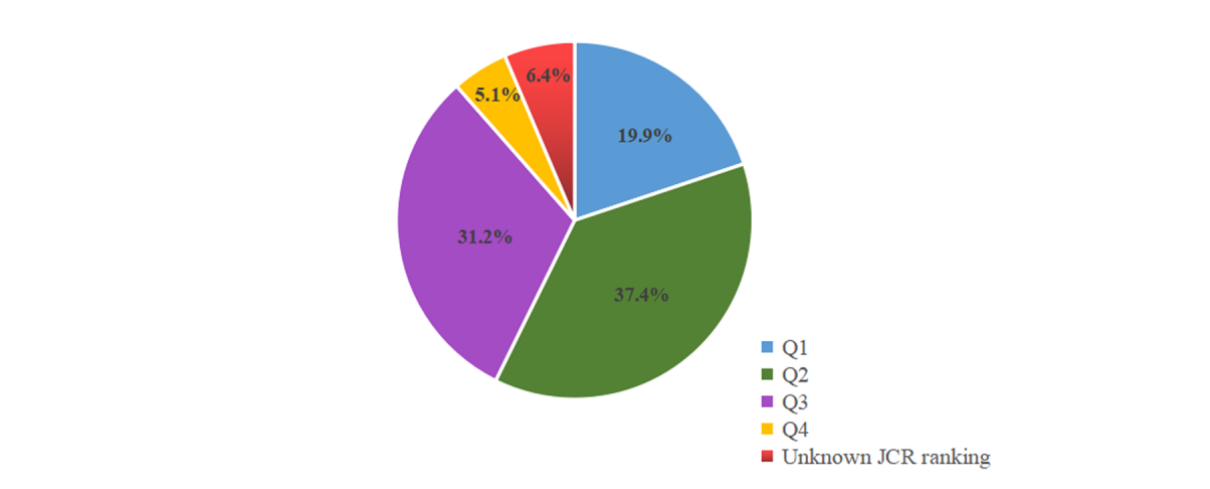
Figure 6. The distribution of the 1566 papers stratified by journal rankings published from Journal Citation Reports (JCR). Q1: first quartile; Q2: second quartile; Q3: third quartile; Q4: fourth quartile.